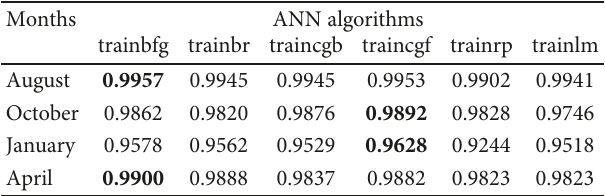
Table 6: ANN algorithm estimation results in Sanliurfa. Months ANN